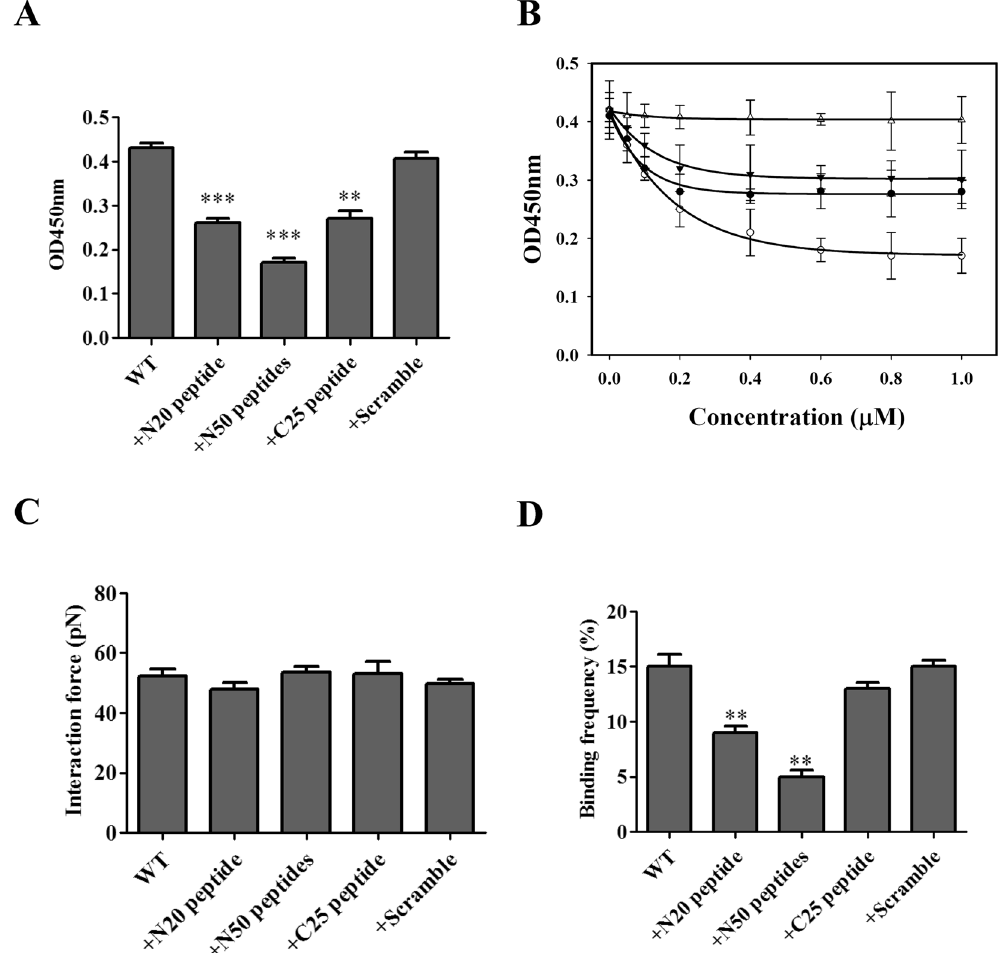
Figure 6. The inhibition of LipL32-TLR2 interaction by synthesized peptides. One μ M synthesized peptides including N20, N50, C25, and scramble peptides were used to inhibit the interaction between LipL32WT and TLR2 protein. ( A ) The inhibition of LipL32 and TLR2 interaction by synthesized peptides as measured by ELISA. ( B ) Dose-dependence ELISA assay of the peptides inhibition. ( C ) The inhibition of LipL32 and TLR2 interaction by synthesized peptides as measured by AFM force-distance curves. ( D ) The AFM binding frequency assay of peptides inhibition the LipL32 and TLR2 interaction. * p < 0.05; ** p < 0.01; *** p <